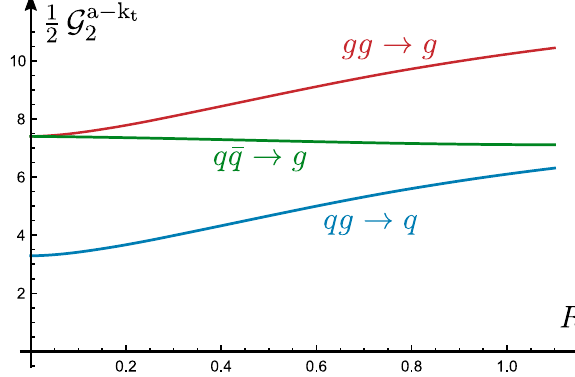
Fig. 6 NGLs coefficient with anti- k t -clustered jets at two